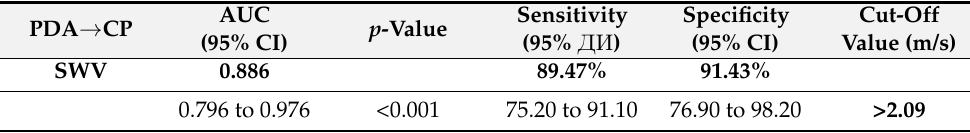
Table 6. Accuracy, Se, and Sp of pSWE for differentiating between CP and PDA. PDA →